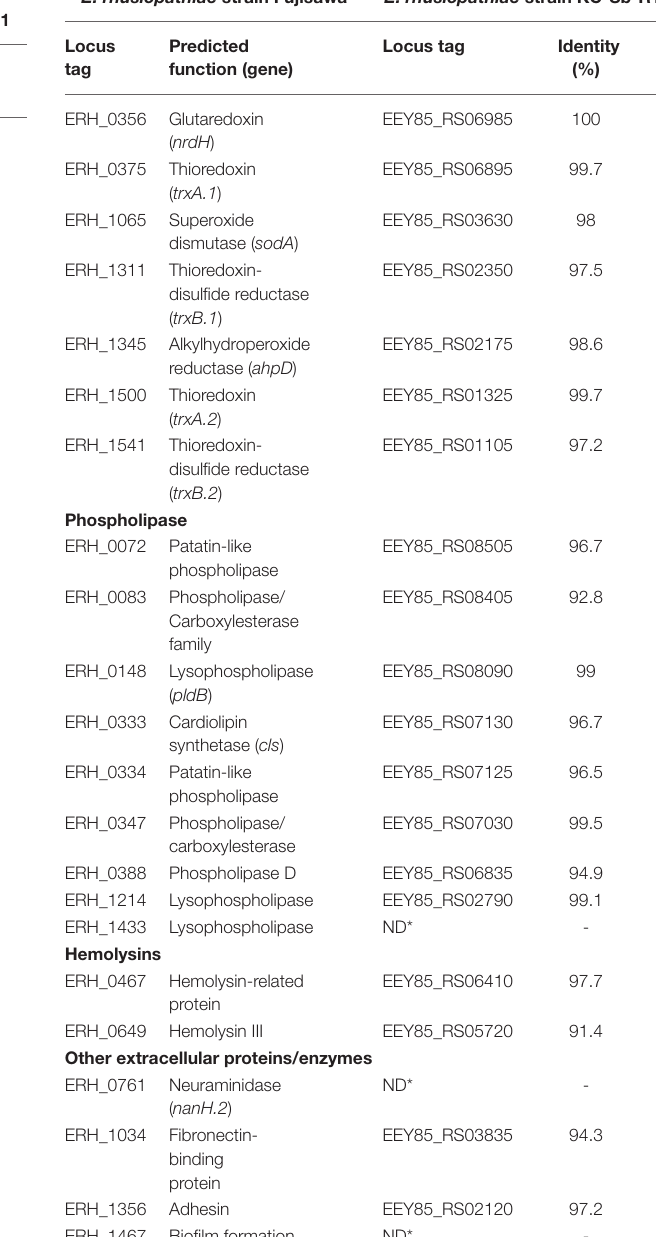
TABLE 1 | Comparisons of potential virulence factors of the E. rhusiopathiae strains Fujisawa and